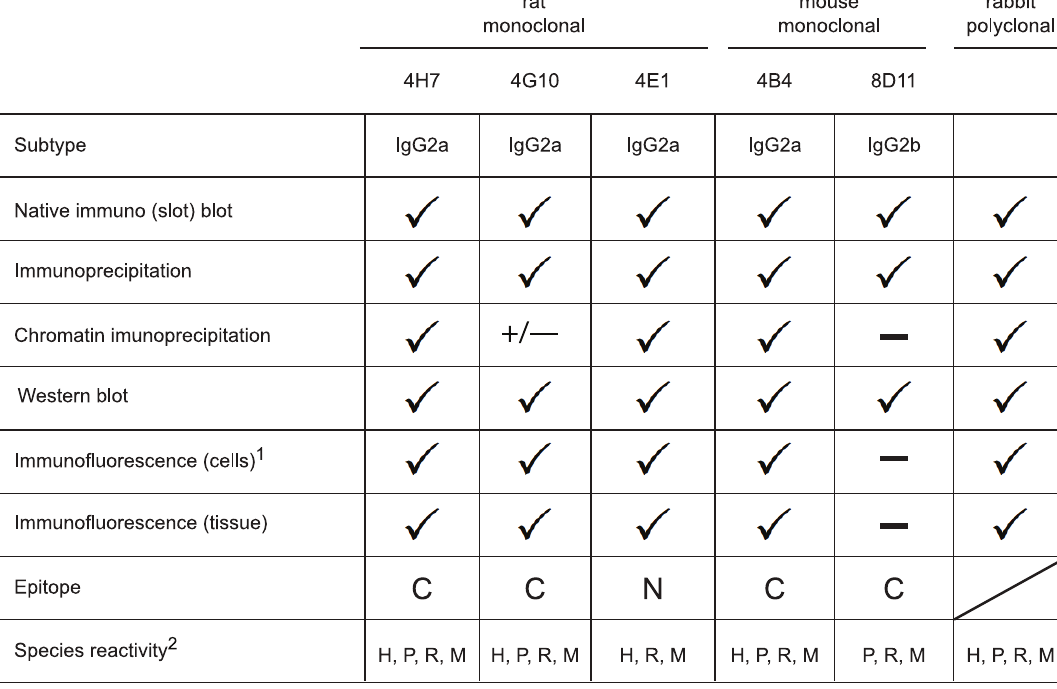
Figure 8. Summary of the characterization of the rabbit, rat and mouse anti MeCP2 antibodies.